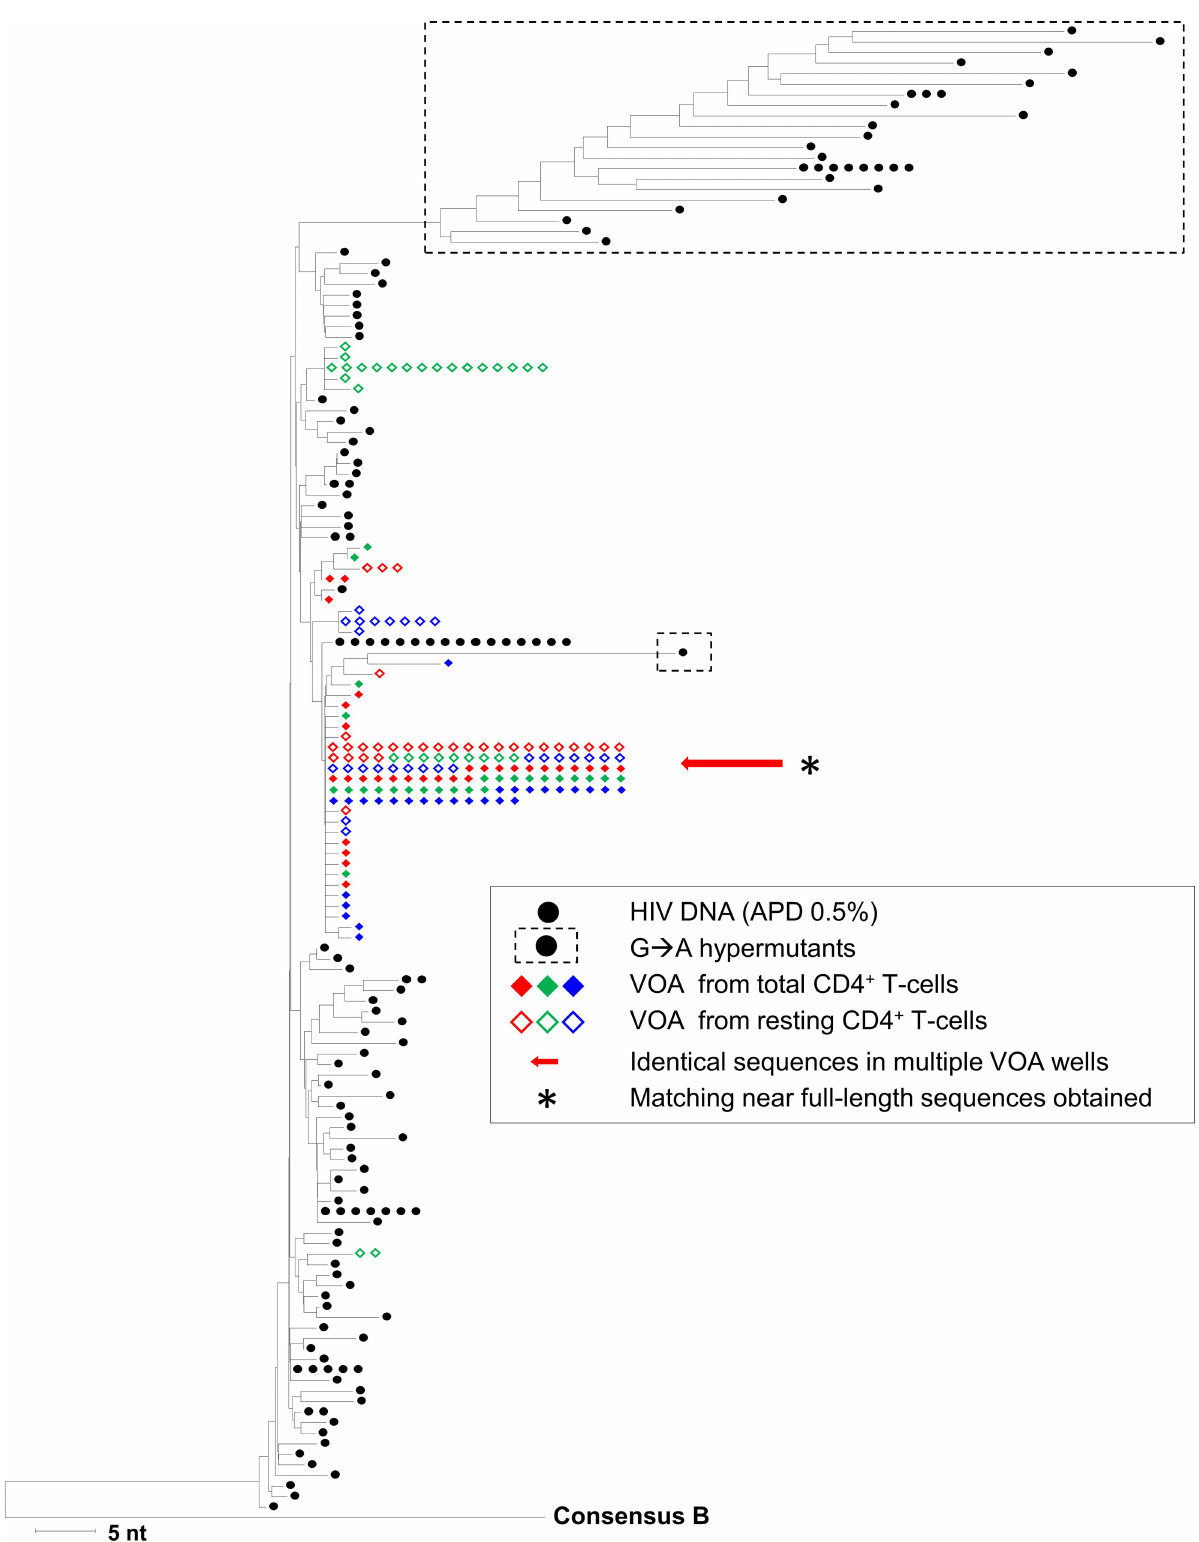
Fig 2. Neighbor-joining distance tree of sequences in p24-positive viral outgrowth assay wells and in HIV DNA sequences from blood mononuclear cells (Donor 1). The tree was constructed using the neighbor-joiningp-distancemethod and rooted to a subtype